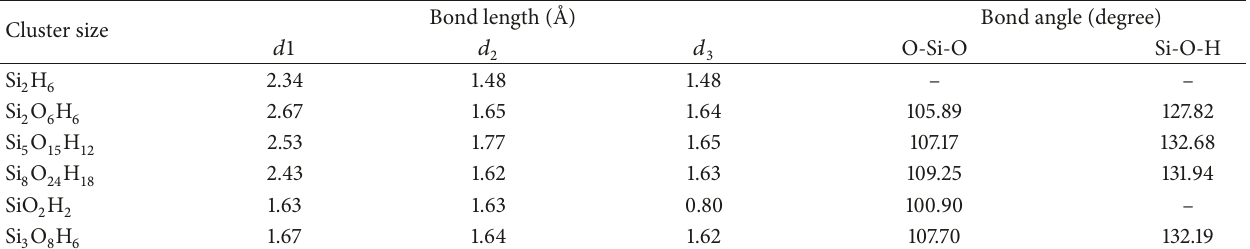
Table 1: Structural properties of the six cluster models with ODC defects in Figure 1. Bond length Cluster size